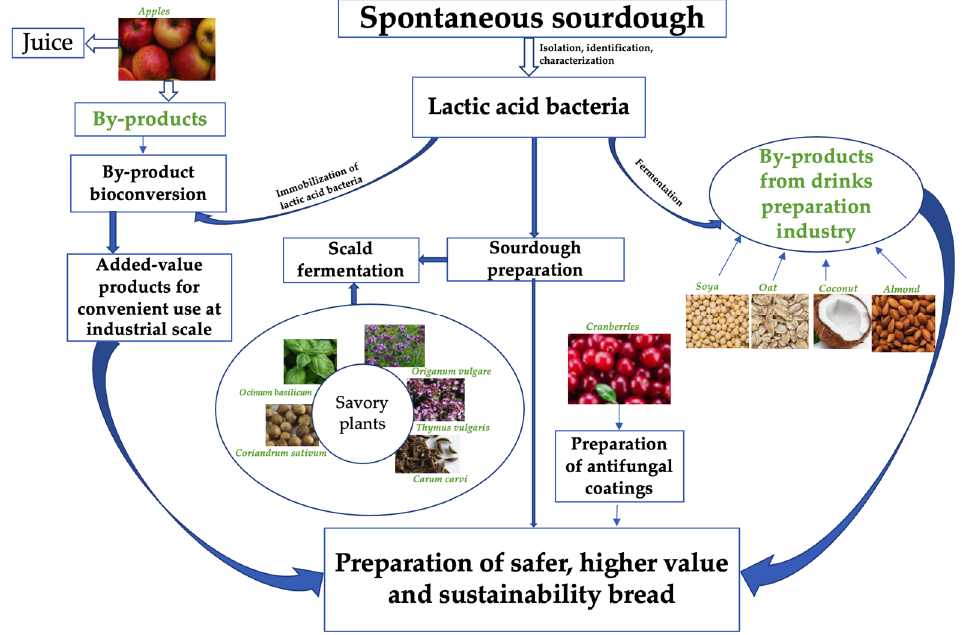
Figure 2. Possible uses of pure lactic acid bacteria starters and their combinations for the preparation of safer, higher-value, and sustainable bread.